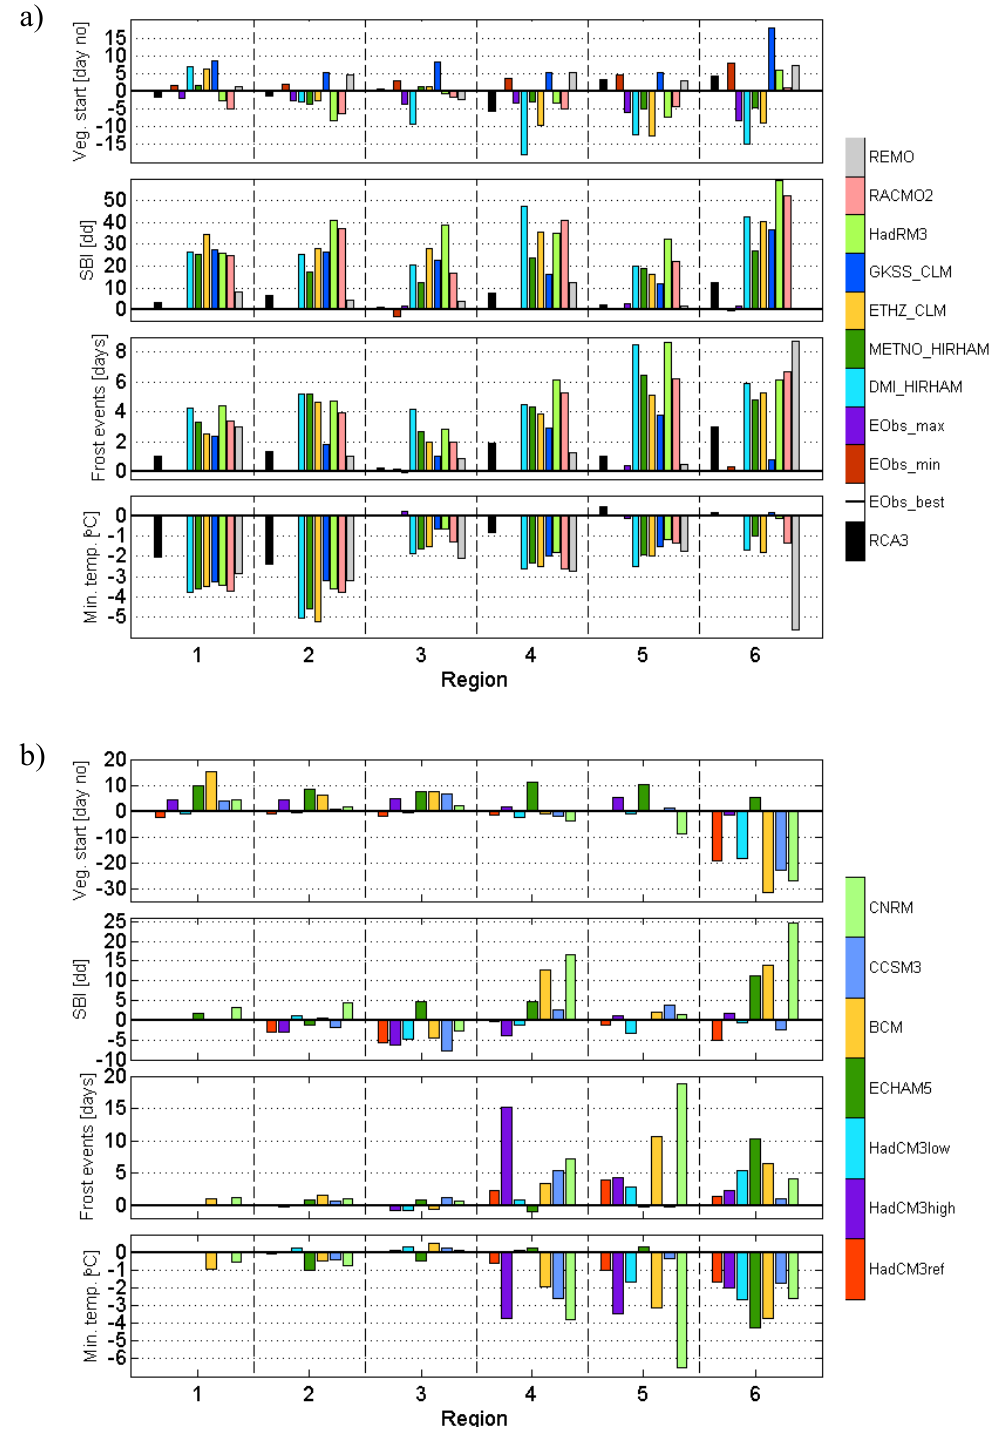
Fig. 6. Deviations from a reference value of the two SBI model comparisons: (a) spread among the RCM ERA ensemble members (i.e. RCM ERA minus E-Obs), (b) spread among the RCA3 GCM ensemble members during the control period (i.e. RCM GCM 1961–1990 minus RCA3 ERA 1961–1990). The four panels of (a) and (b) show the different SBI model variables (cf. Table 1), from top to bottom: the onset of the vegetation period; SBI index; number of frost events; and minimum temperature during an event.